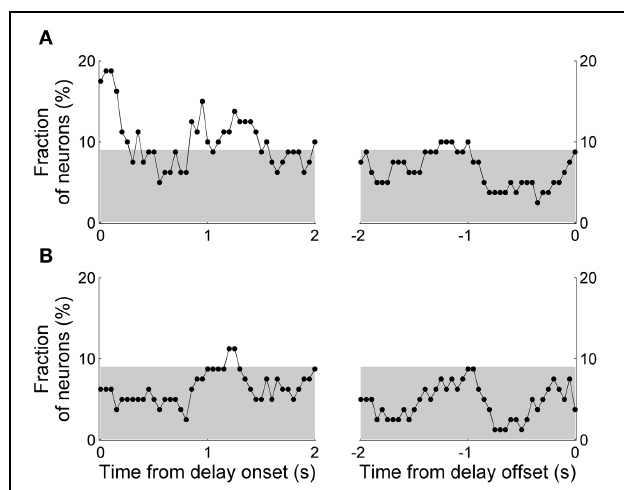
FIGURE 7 | Results of regression analysis. The graphs show fractions of neurons with significant dependence of their activity on the animal’s previous (A) or upcoming (B) goal choice (Equation 1) during a 1-s time window that was advanced in 50-ms steps. As in Figure 6 , the first data point of the left graph (time from delay onset) corresponds to the first 1s of the delay period, and the last data point of the right graph (time from delay offset) corresponds to the last 1s of the delay period. The gray shading indicates the chance level (binomial test, alpha =